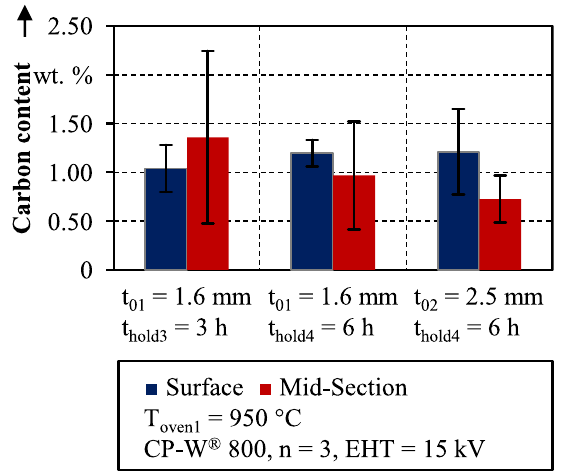
Fig. 14. Carbon content of samples carburized at 950 ° C measured via